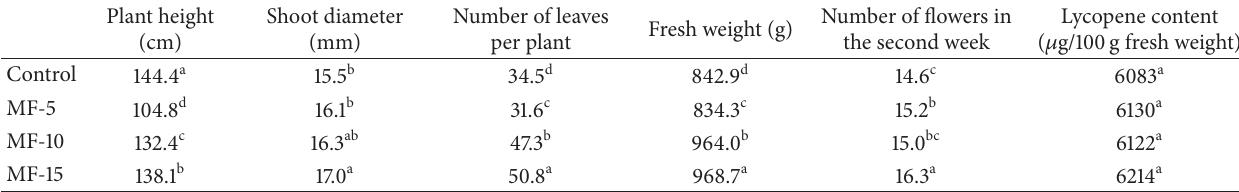
Table 2: Mean values of main plant characteristics and quality measurements.